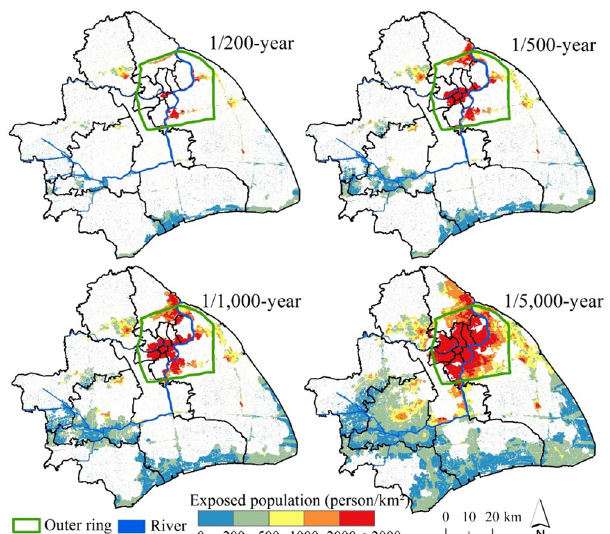
Figure 7. Spatial distribution